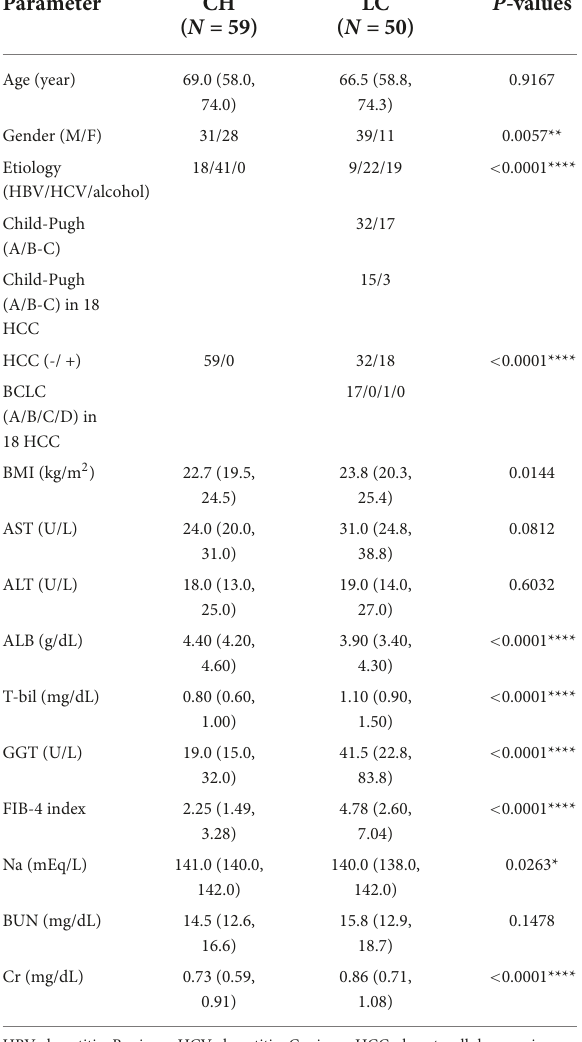
TABLE 1 Demographic and clinical characteristics of